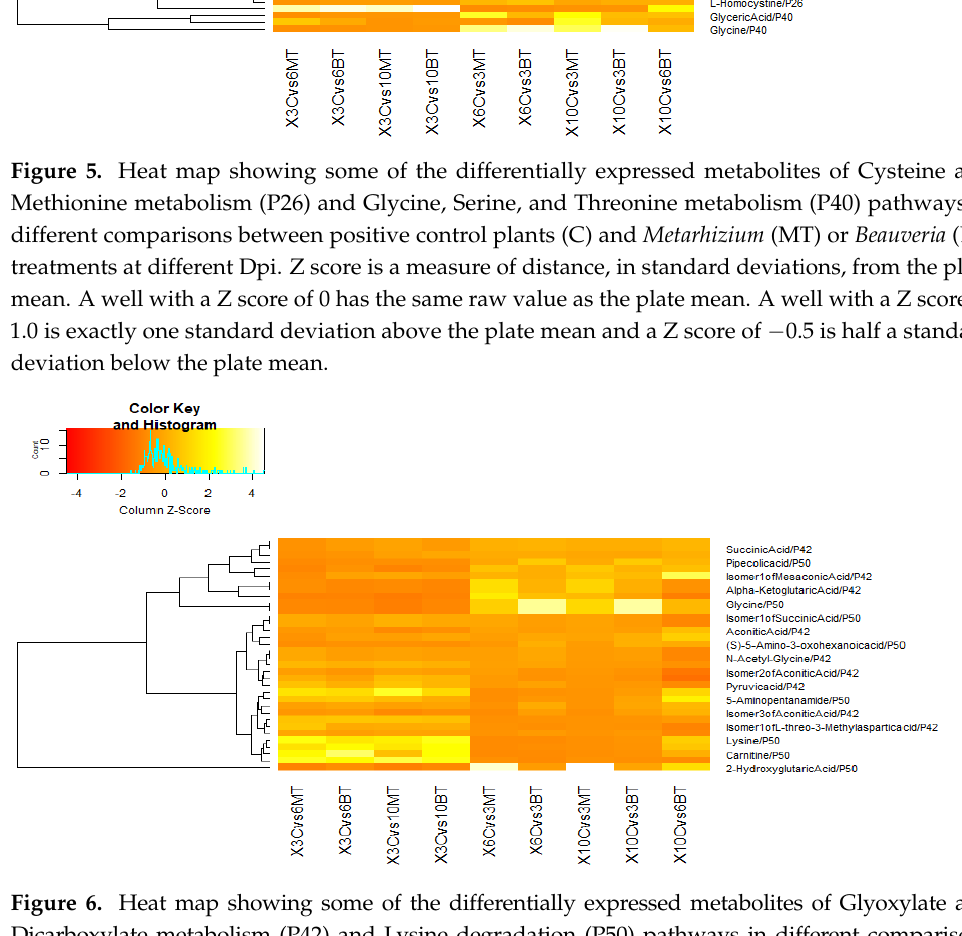
Figure 6. Heat map showing some of the differentially expressed metabolites of Glyoxylate and Dicarboxylate metabolism (P42) and Lysine degradation (P50) pathways in different comparisons between positive control plants (C) and Metarhizium (MT) or Beauveria (BT) treatments at different Dpi. Z score is a measure of distance, in standard deviations, from the plate mean. A well with a Z score of 0 has the same raw value as the plate mean. A well with a Z score of 1.0 is exactly one standard deviation above the plate mean and a Z score of −0.5 is half a standard deviation below the plate mean.